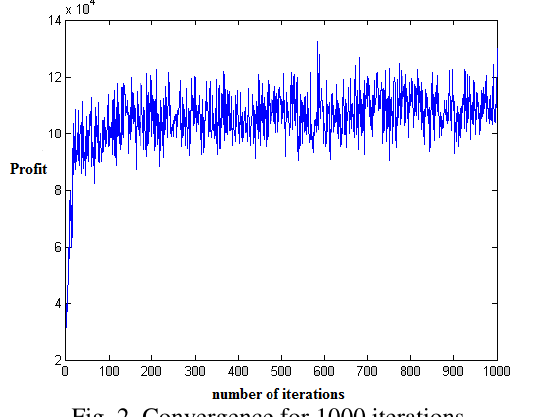
Fig. 4. Convergence for 3000 iterations